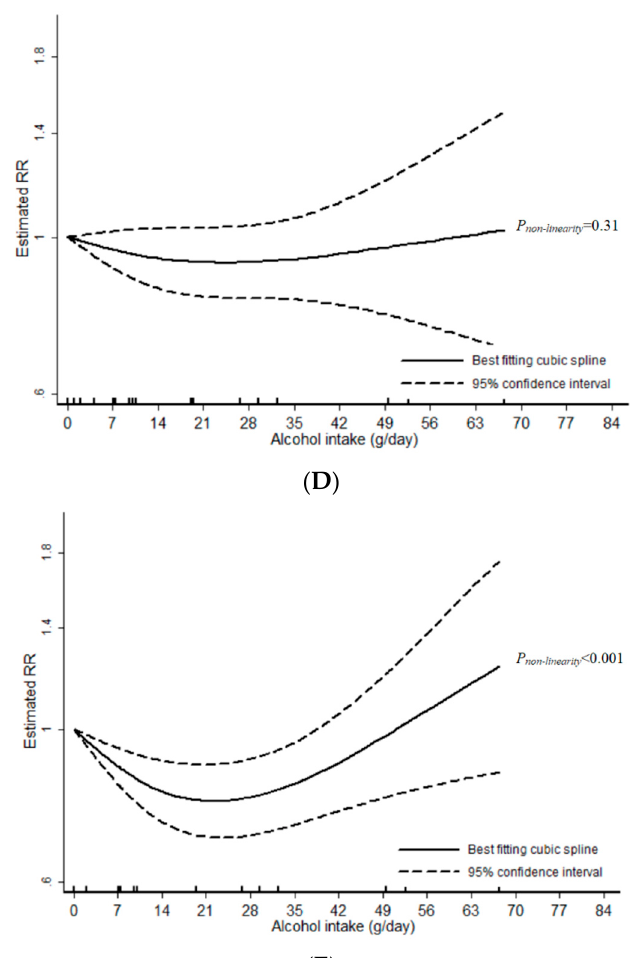
Figure 4. Meta-analyses of beer intake and prostate cancer risk: ( A ) linear analysis with non-aggressive PCa; ( B ) non-linear analysis with non-aggressive PCa; ( C ) linear analysis with aggressive PCa; ( D ) non-linear analysis with aggressive PCa; ( E ) non-linear analysis with aggressive PCa (Sensitivity). Abbreviations: PCa, prostate cancer; RR, relative risk; CI, confidence interval.